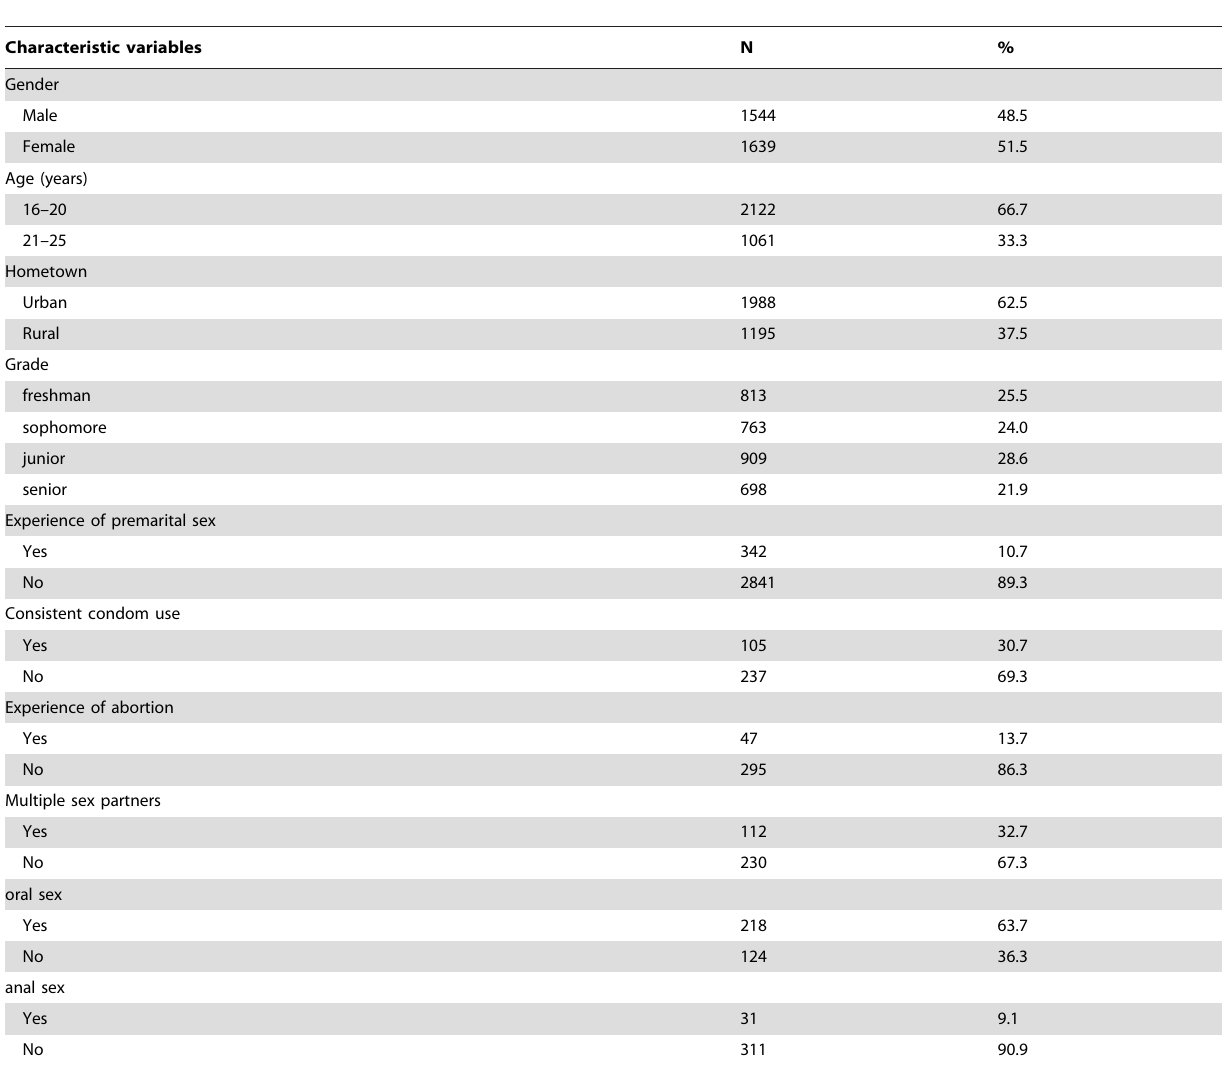
Table 1. Socio-economic, demographic characteristics and sexual and reproductive risk behaviors of the